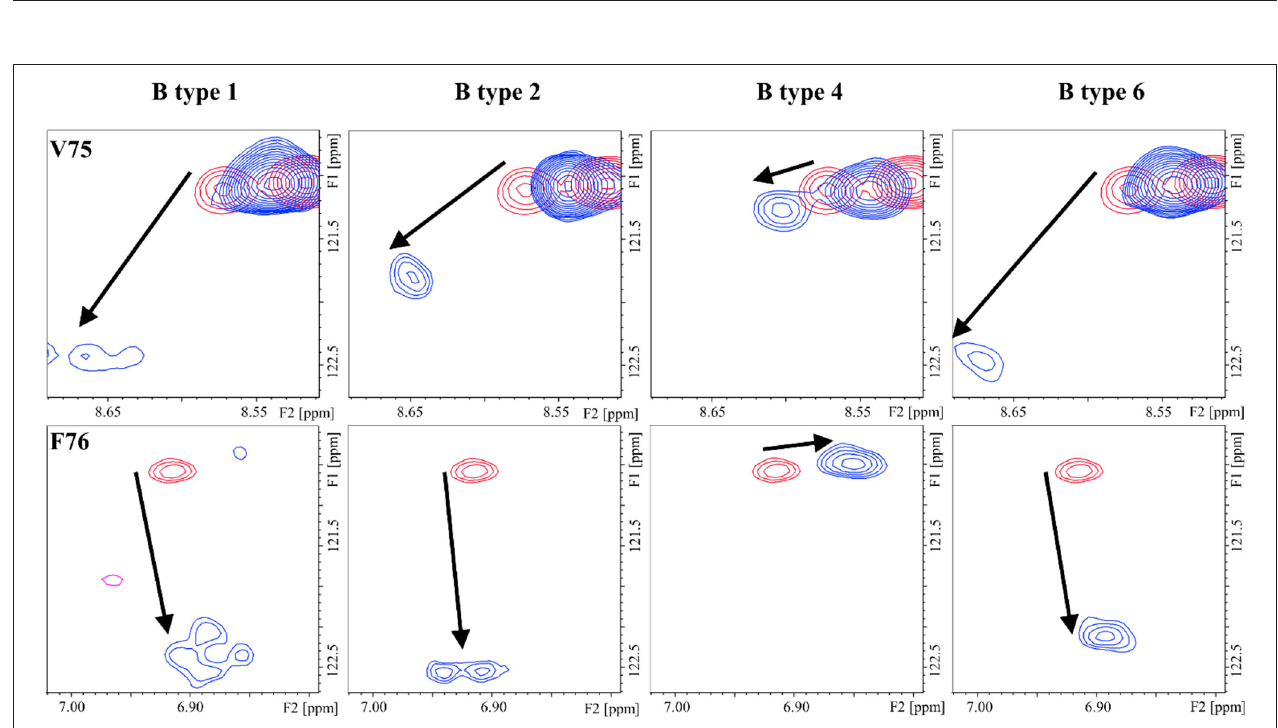
FIGURE 5 | 1 H- 15 N HSQC: chemical shift perturbation of residues V75 and F76 of Gal-4N in the presence of the B antigens types-1, -2, -4, and -6.